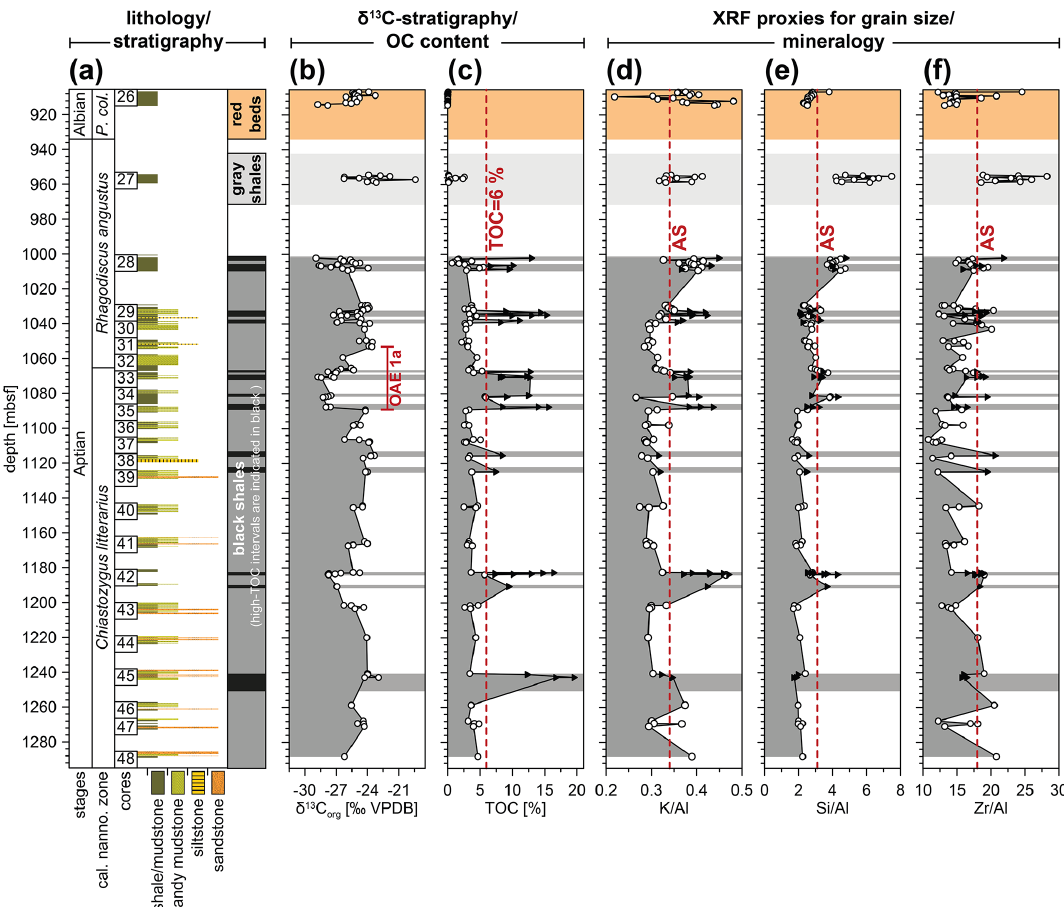
Figure 2. Stratigraphic framework and inorganic geochemistry at DSDP Site 361: (a) stage assignment, calcareous nannofossil zonation, and lithology of the studied sediment sequence; (b) bulk δ 13 C org ; (c) total organic carbon content; (d) K / Al ratios; (e) Si / Al ratios; and (f) Zr / Al ratios. Black triangles with background shading indicate high-TOC black shales ( > 6% TOC). Dashed lines in panels (d) – (f) represent average shale (AS) ratios. Bulk δ 13 C org data and TOC content are taken from Dummann et al. (2020). P. col. is an abbreviation for Prediscosphaera columnata